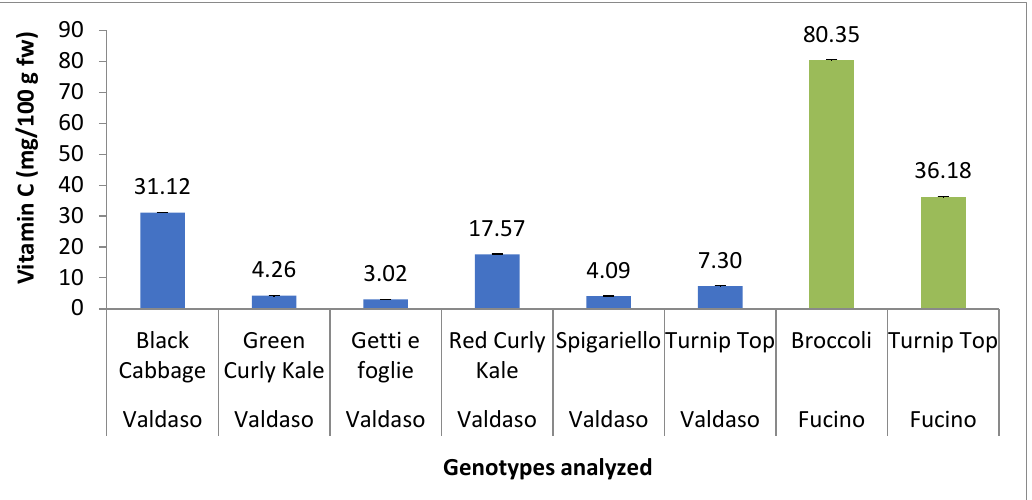
Figure 1. Vitamin C content in samples analyzed during the 1st year. Data are presented as means ± standard error.